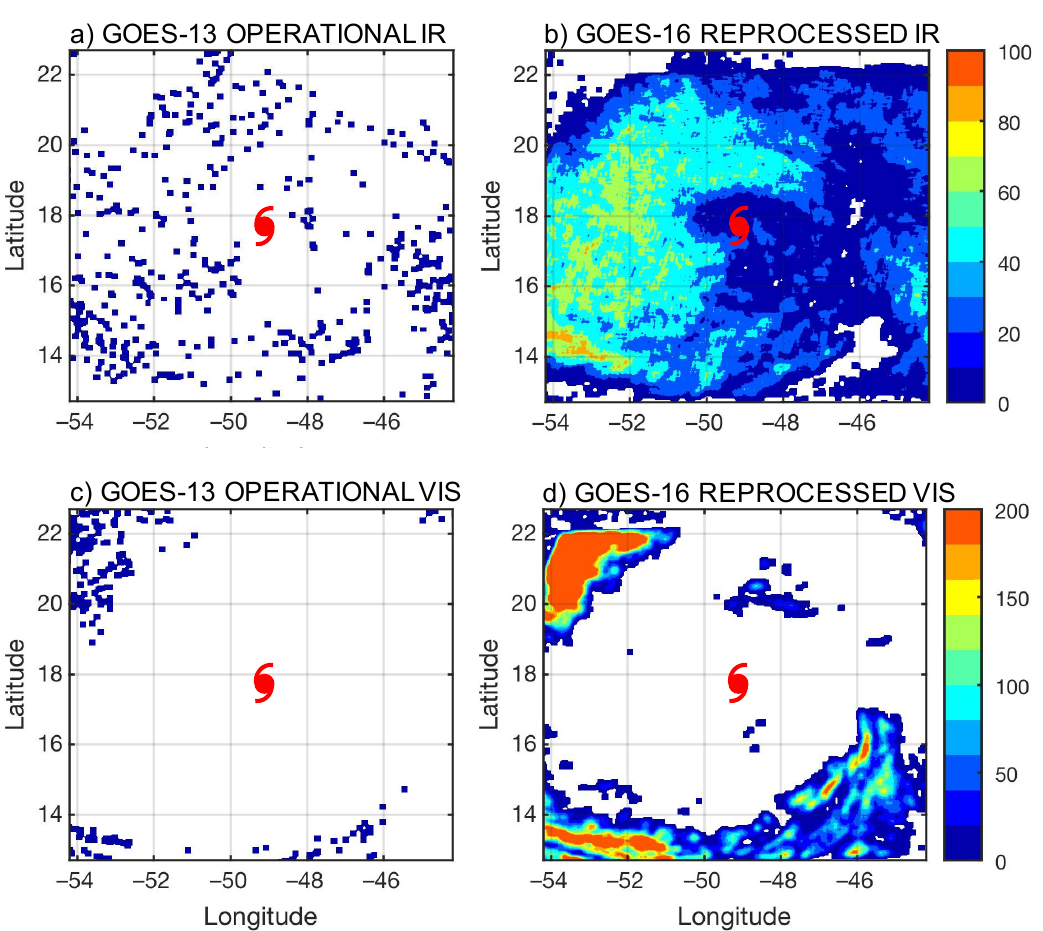
Figure 3. Illustration of AMV observation density available for assimilation into HWRF for one analysis cycle during the Hurricane Irma (2017) case study. The top row depicts the total number of IR-channel AMVs contained in the 100–300 hPa layer, summed over 10 km × 10 km grid boxes, derived from ( a ) GOES-13 operational, and ( b ) GOES-16 reprocessed using 1-min ABI imagery. The bottom row depicts the total number of VIS-channel AMVs contained in the 700–1000 hPa layer derived from ( c ) GOES-13 operational, and ( d ) GOES-16 reprocessed using 1-min ABI imagery. The red hurricane symbol indicates the center of Irma at the analysis time.